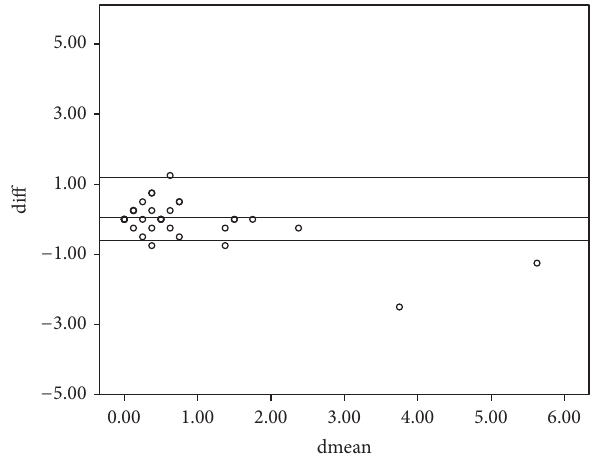
Figure 5: Bland-Altman plots comparing refractive measurements between autorefraction and retinoscopy (total